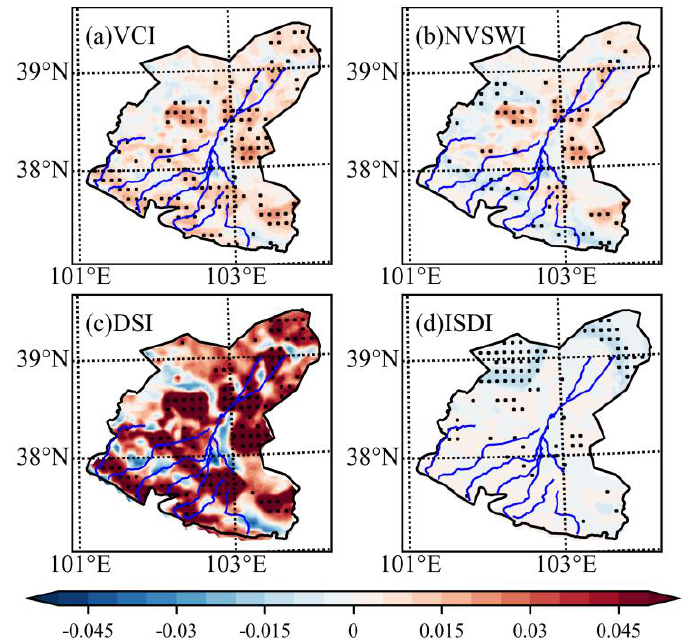
Figure 8. Spatial distribution of trends: ( a ) VCI, ( b ) NVSWI, ( c ) DSI, and ( d ) ISDI, over 1982–2020. The black dots represent significance above 95%.